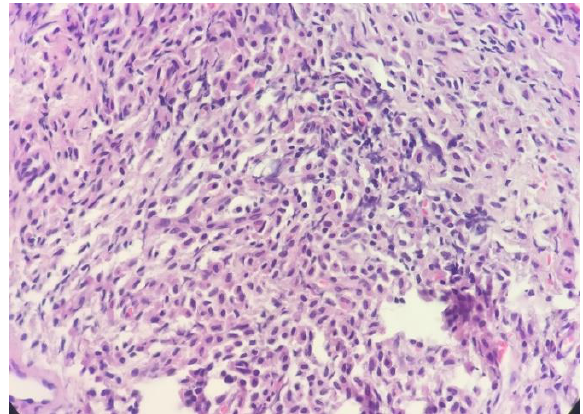
Figure 6. Peritoneal biopsy showed mast cell distribution.